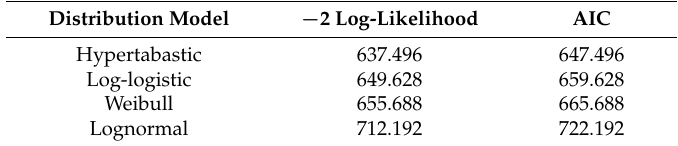
Table 2. Comparison of Akaike Information Criterion for various